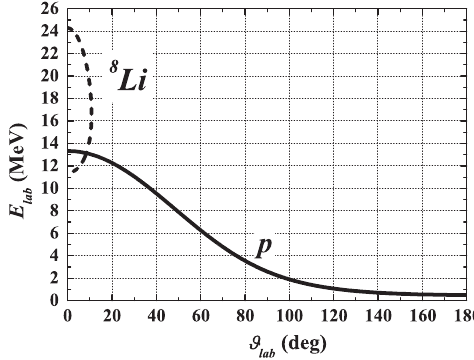
FIG. 21. The expected laboratory energy vs laboratory angle correlations for protons (solid line) and 8 Li (dashed line) from the two-body kinematics. The calculation is performed considering 8 Li in the ground